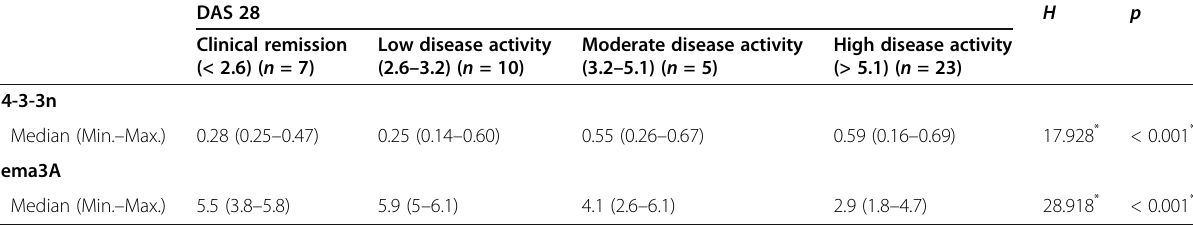
Table 4 Relation between DAS 28 with 14-3-3n and Sema3A in patients ’ group ( n = 45) DAS 28